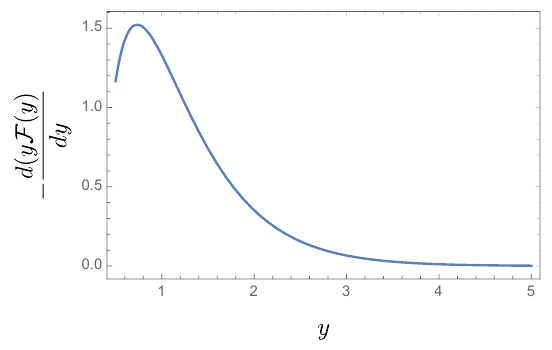
Figure 3 . Plot of the function − ( y F ( y )) 0 . It is positive for arbitrary y > 0